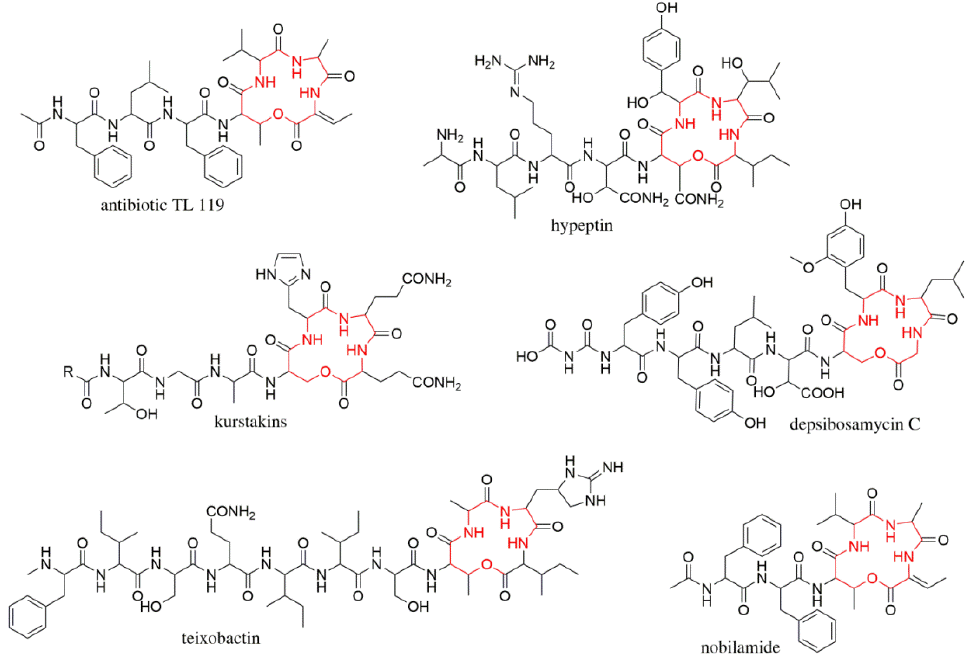
Figure 1. Structure comparison of compounds with a similar side-chain-to-tail lactone ring (red) formed by an intramolecular reaction of β - hydroxy amino acids and the C -terminus.